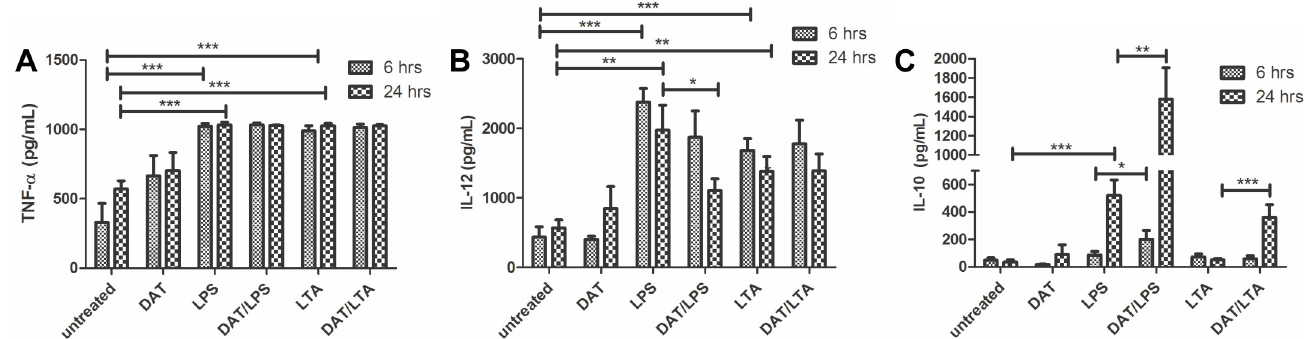
Fig 5. Di- O -acyl trehalose counteracts the effects of LPS and LTA cytokine production by dendritic cells. Regarding cytokines, LPS treated DCs upregulated TNF- α , IL-12, and IL-10 (p � 0.0005; unpaired t Student’s test) (A-C). LTA upregulated TNF- α and IL-12 (p < 0.001; unpaired t Student’s test) (A-C). DAT modified cytokine release triggered by LPS reducing greatly IL-12, and increasing IL-10 (p < 0.005; unpaired t Student’s test) (B, C). The results shown were obtained in five independent experiments.